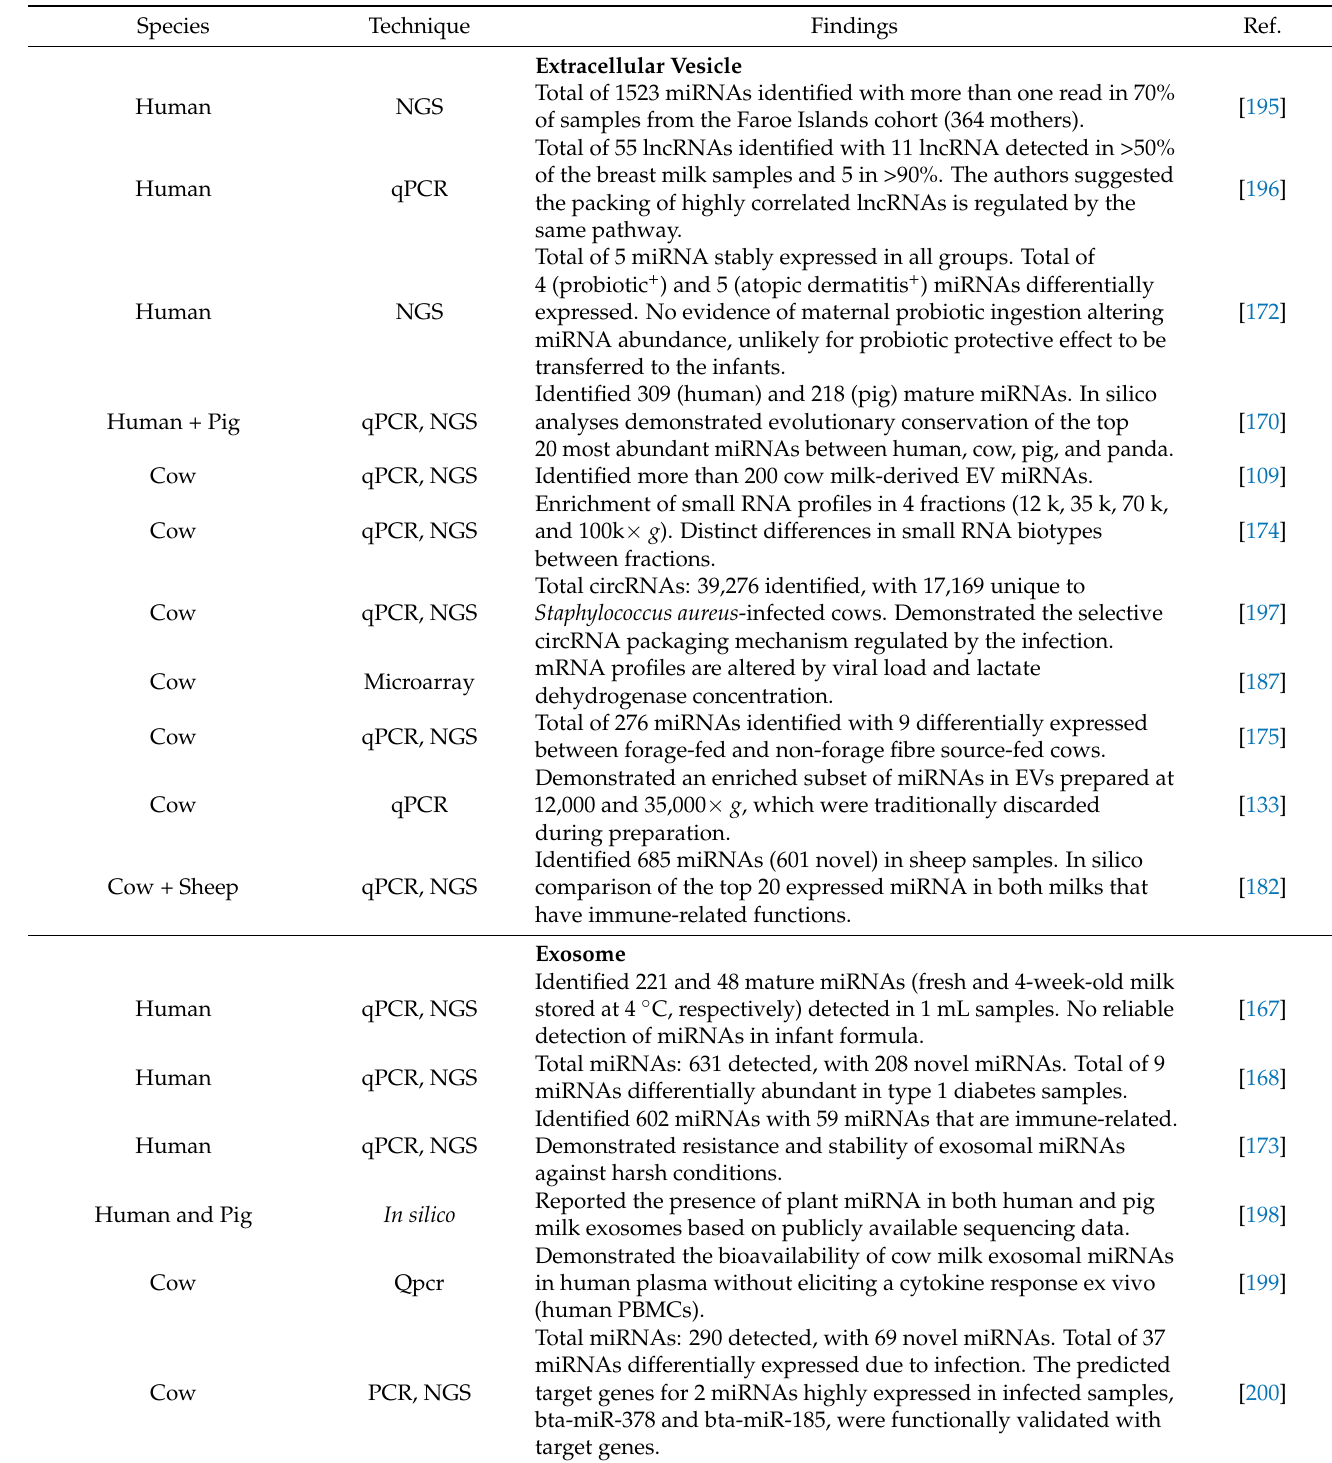
Table 5. Major findings of nucleic acid studies conducted on EVs of different mammalian milk used to characterise the RNA composition of milk-derived EVs and